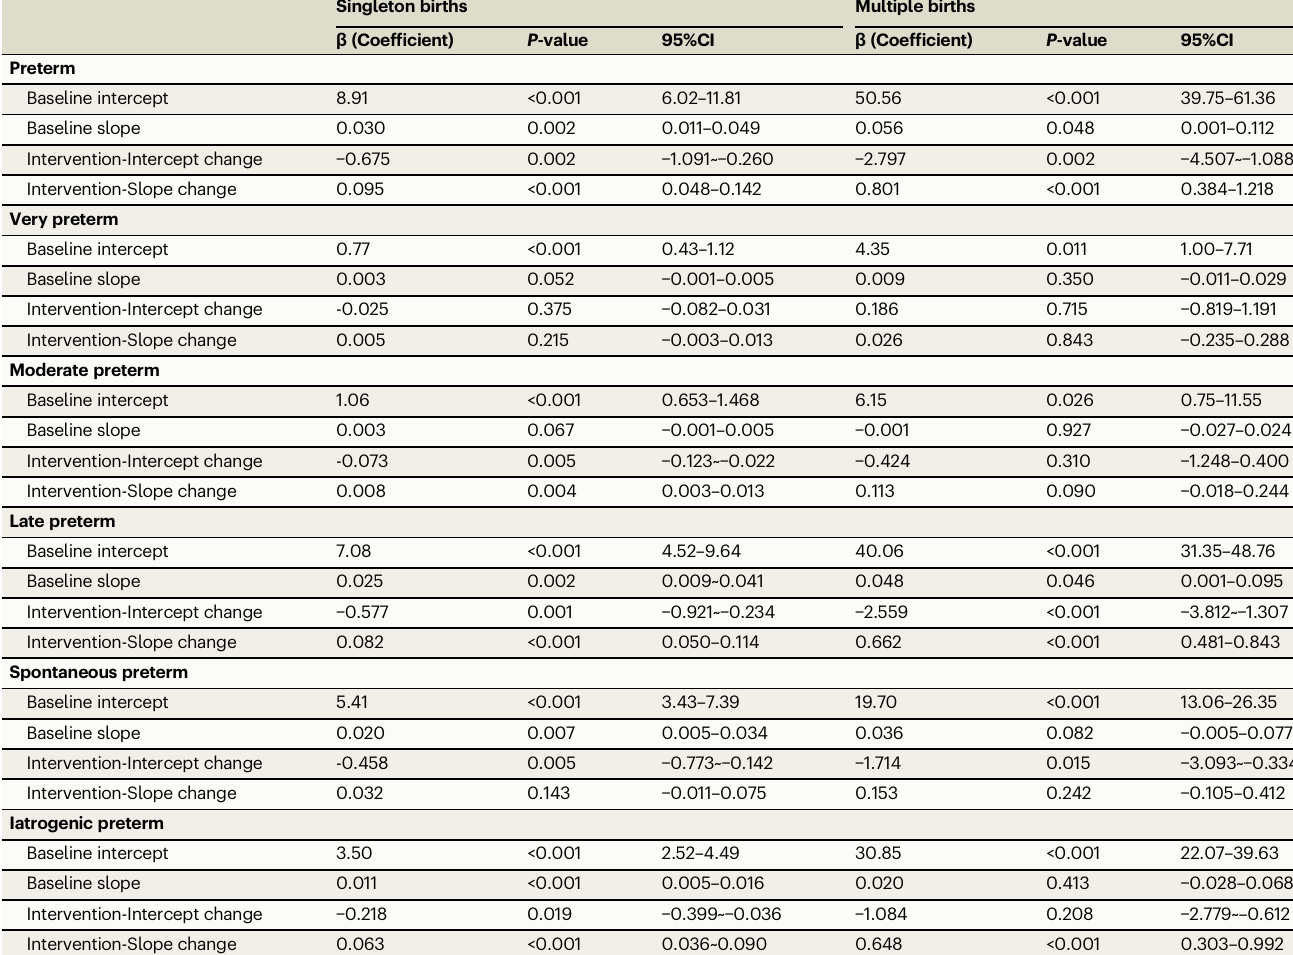
Table 2 | Interrupted time series analysis of monthly preterm birth rate in singleton and multiple pregnancies in China, 2012 –